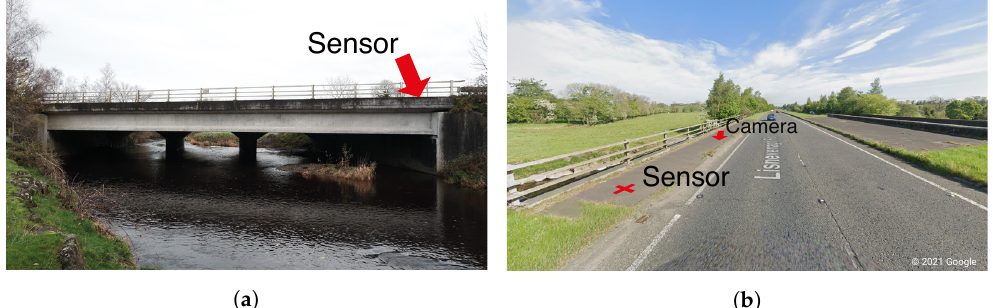
Figure 12. Photographs of ( a ) West elevation of bridge and ( b ) Northbound approach to bridge showing sensor and camera locations.